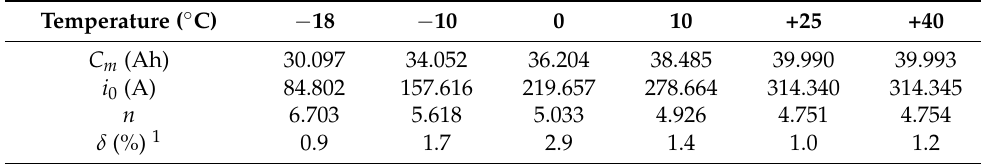
Figure 1. Dependence of HR3781162227 battery capacity on discharge current in standardized coordinates at different temperatures. Parameters C m and i 0 are taken from Table 1. Table 1. Optimal values for Equation (6) parameters at different temperature values.